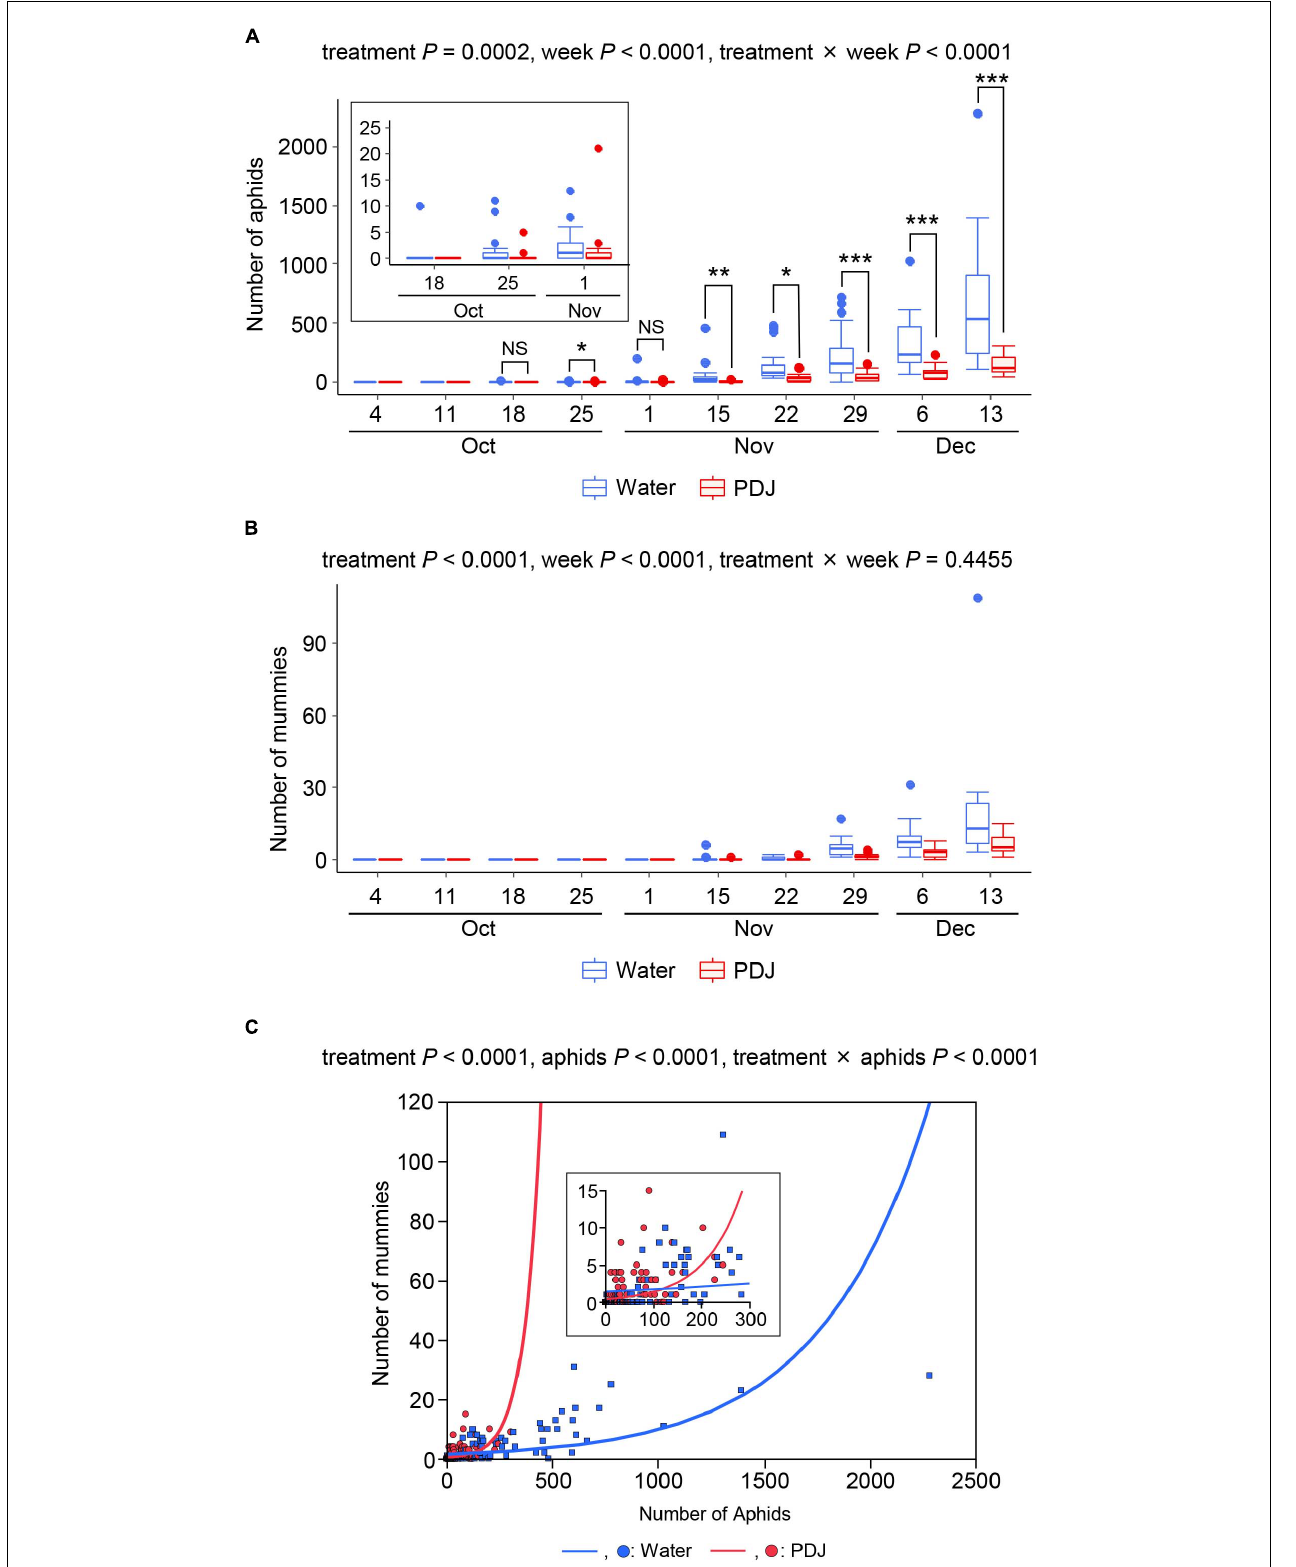
FIGURE 1 | Occurrences of aphids (A) and mummies (B) on Japanese radish plants in the field during the observation period. (C) Poisson regression analysis of the relationship between the numbers of mummies and that of the aphids. NS: 0.05 < P , *0.01 < P < 0.05, **0.001 < P < 0.01, and *** P < 0.001 (GLMM).